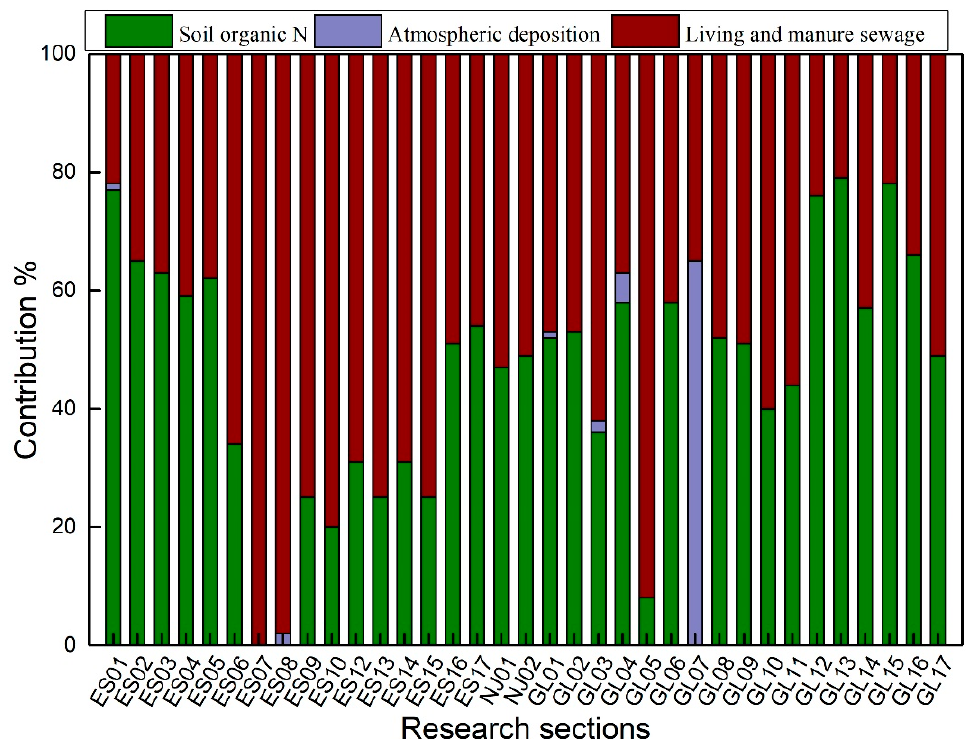
Figure 3. The contribution rate of nitrogen to the SHR during low flow season.